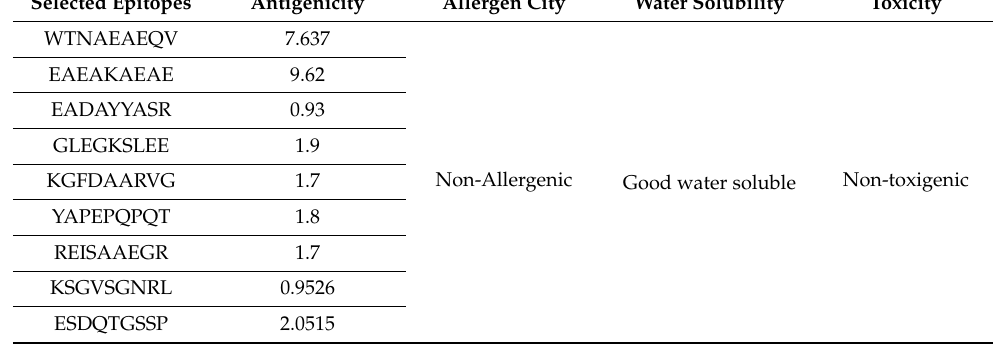
Table 2. Selected epitopes for vaccine construct.